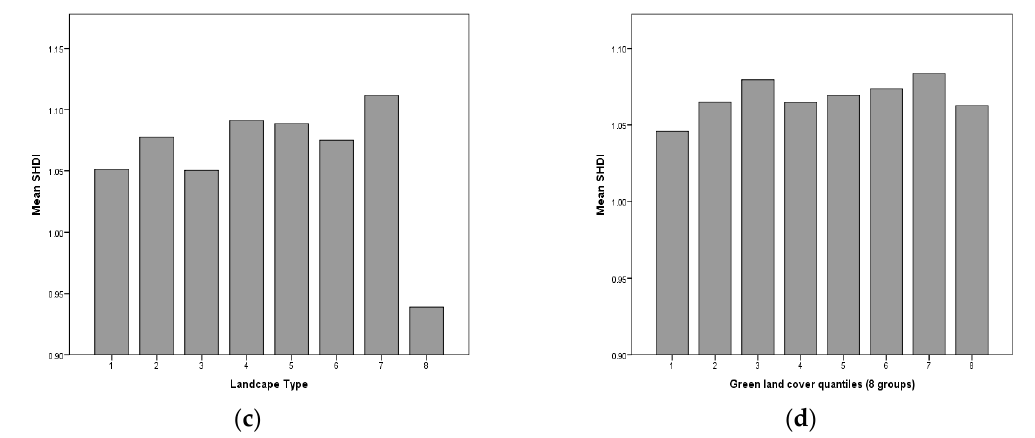
Figure 12. ( a ): Landscape types arranged in ascending order of green space cover and mean IMD score; ( b ): Eight quantile groups by percentage green/blue cover and respective mean IMD scores; ( c ): Landscape types arranged in ascending order of green/blue space cover and mean Shannon’s diversity index; ( d ): Eight quantile groups by percentage green space cover and Shannon’s diversity index (SHDI). Key: Type 1: Dense Greyscape; Type 2: Garden City; Type 3: Leafy Residential; Type 4: Peri-urban Fringe; Type 5: Encapsulated Countryside; Type 6: Amenity Suburbs; Type 7: Parklands; Type 8: Rural Hinterland.